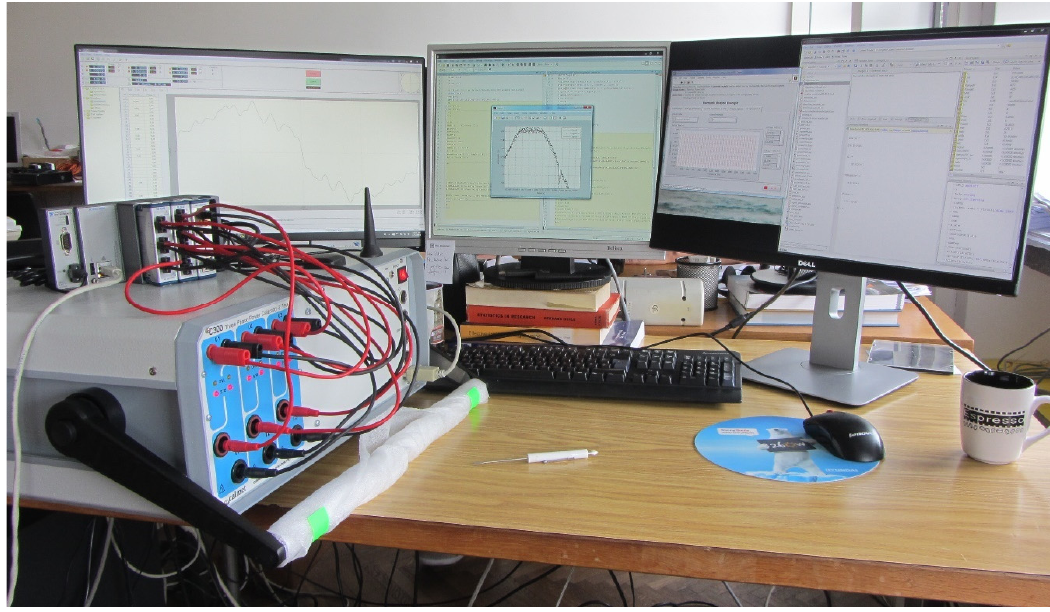
Figure 13. Laboratory and measurement system.